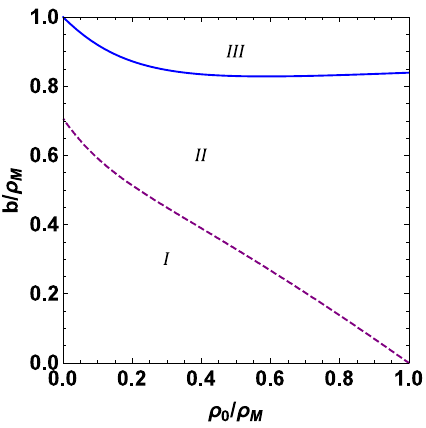
Figure 4 . The parameter regions of existence and nonexistence of black hole shadow for a rotating squashed KK black hole. The black hole shadow exists only in the region I and there is no shadow in the region II. In the region III, there is no horizon and the metric (2.20) does not describe geometry of a black hole. Here we set (cid:26) M = 1.